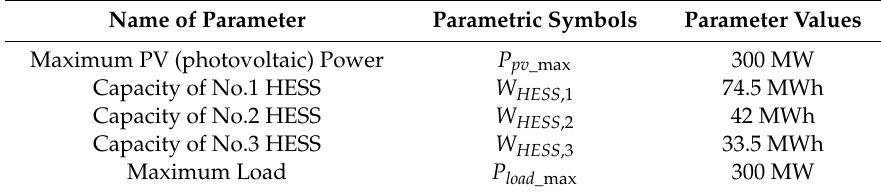
Table 1. Partial parameters of photovoltaic microgrid.